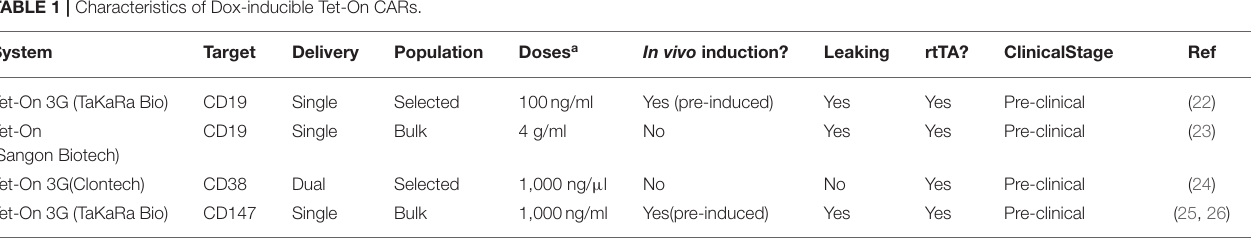
TABLE 1 | Characteristics of Dox-inducible Tet-On